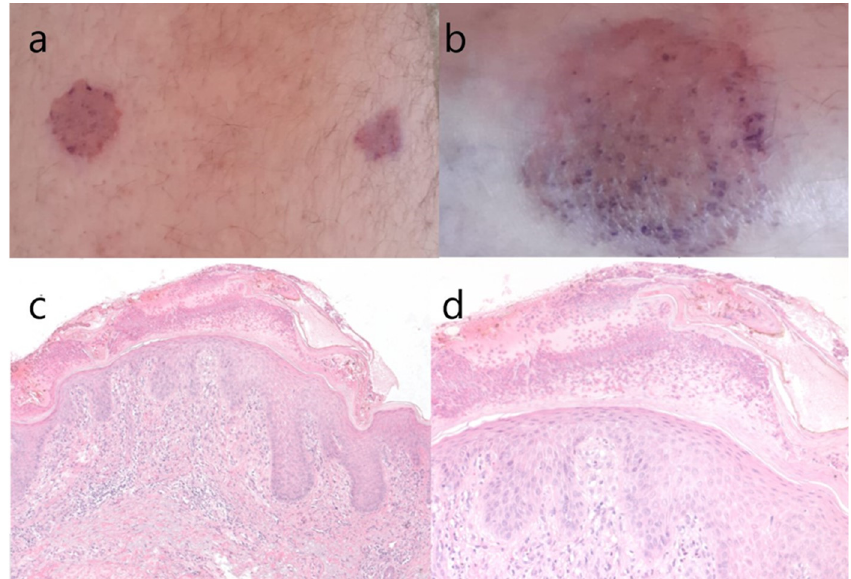
Figure 2. ( a – d ) Macroscopic aspect of skin lesion from the anterior thigh and the distal leg ( a , b ); hematoxylin & eosin stain, original magnification 100× ( c ); original magnification 200× ( d ). We can observe superficial vesicles with neutrophils, hyperkeratosis, epidermal hyperplasia with spongiosis, hypergranulosis (a pronounced granular cell layer) and exocytosis of lymphocytes, which are histopathological signs suggestive of nummular eczema or discoid eczema (clinically “silver dollar sized patches”).